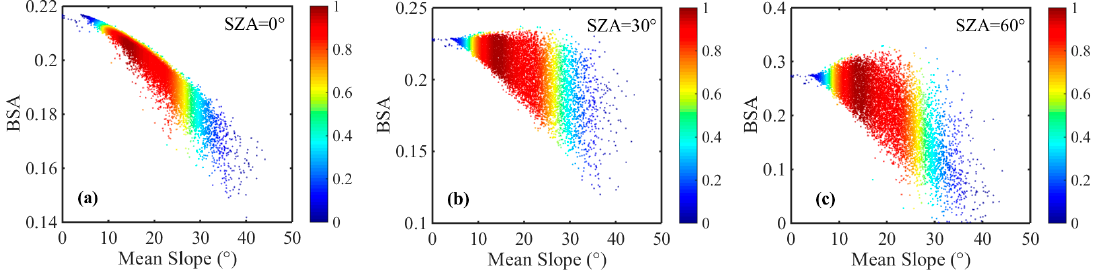
Figure 7. BSA variation with a mean slope under different SZAs: ( a ) 0°; ( b ) 30°; and ( c ) 60°. The colors refer to the density of points (from highest (red) to lowest (blue)).